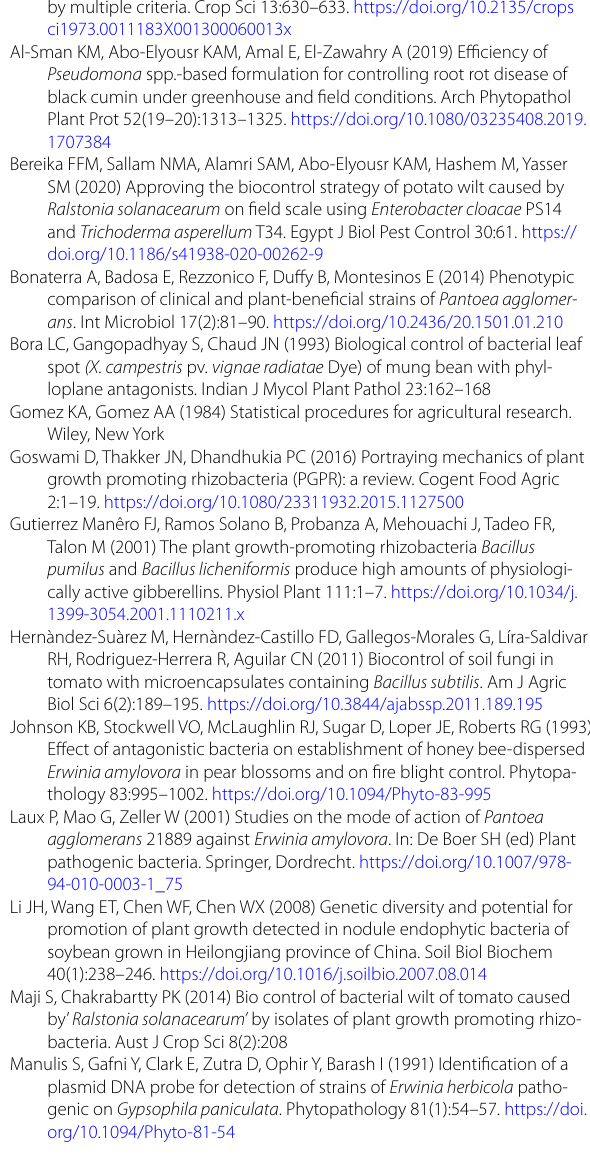
Values in the same column followed by a similar letter are not significantly different as determined by the LSD test (P